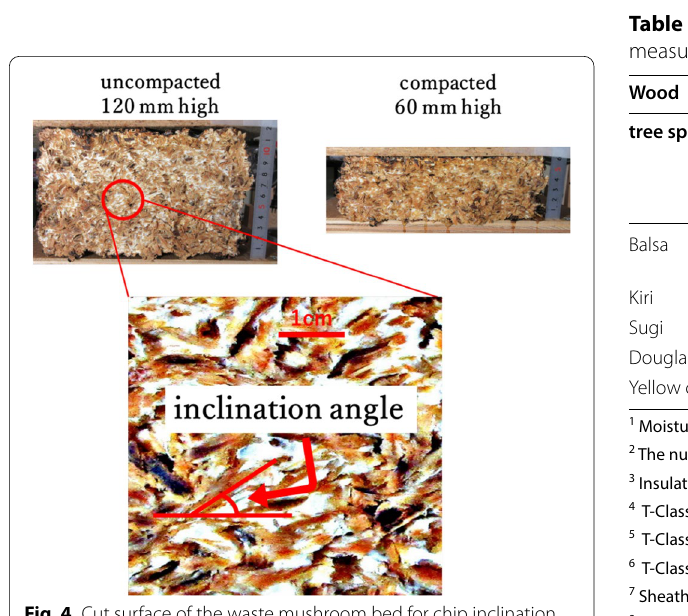
Fig. 4 Cut surface of the waste mushroom bed for chip inclination angle measurement